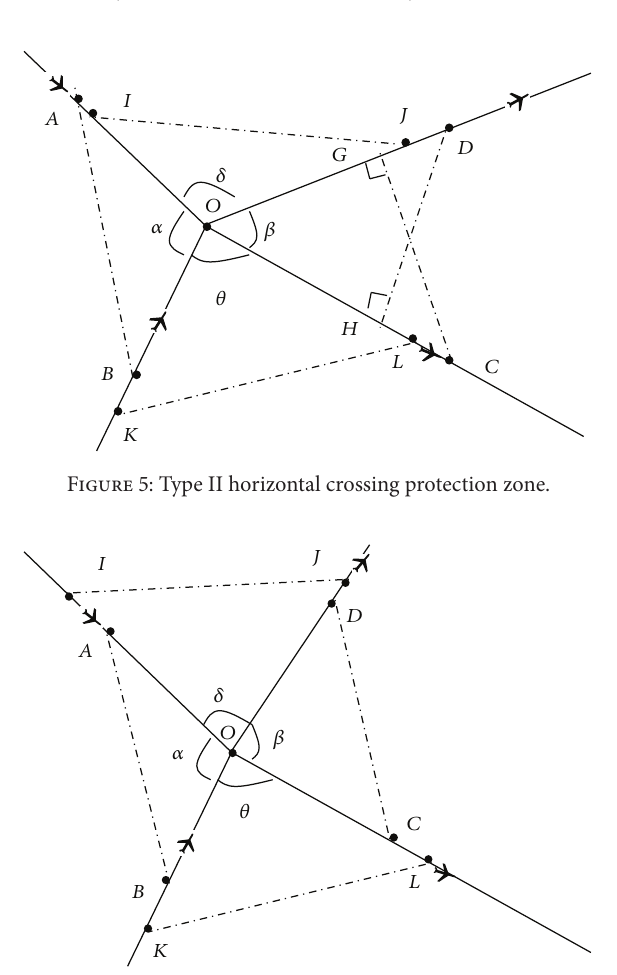
Figure 6: Type III horizontal crossing protection zone.